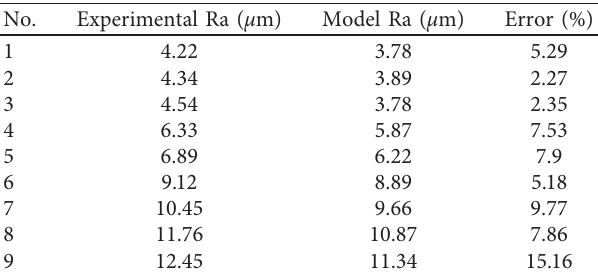
Table 3: Comparison of surface roughness values.